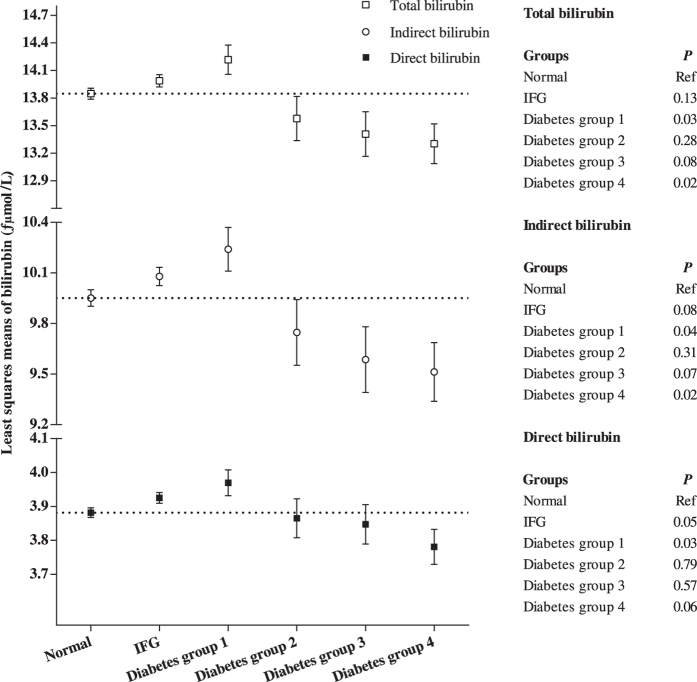
Least square means of three types of bilirubin levels in different groups.Least square means were adjusted for age, sex, BMI, waist circumference, education level, smoking status, drinking status, physical activity, family history of diabetes, history of hypertension, alkaline phosphatase, alanine aminotransferase, aspartate aminotransferase, triglyceride, high density lipoprotein and fasting plasma glucose. Black square = total bilirubin; white square = direct bilirubin; white circles = indirect bilirubin. Diabetes group 1: duration ≤1 year; Diabetes group 2: duration >1 year while ≤5 years; Diabetes group 3: duration >5 year while ≤10 years; Diabetes group 4: duration >10 years.